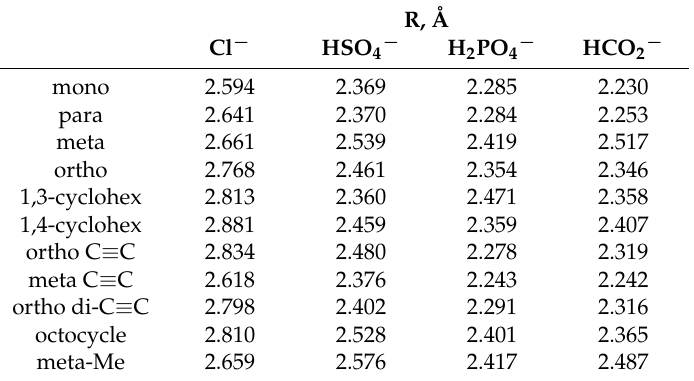
Table 4. Shorter of two R(Sn ··· X) (X = Cl,O) distances (Å) in indicated complexes.